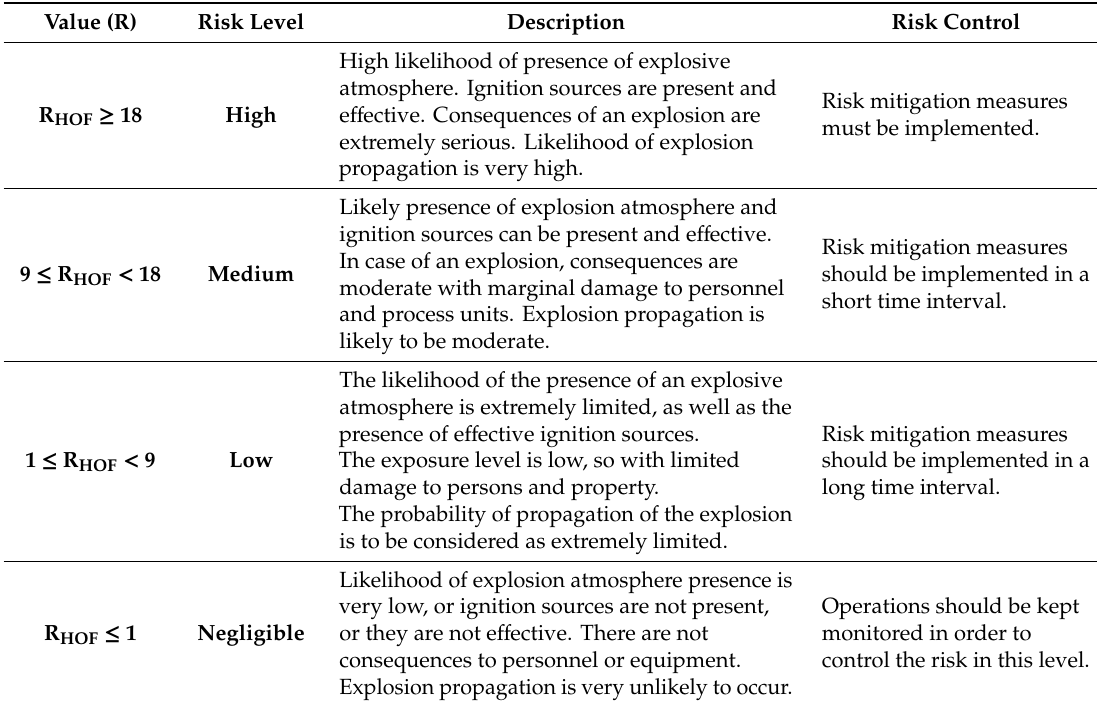
Table 4. Risk-based decision making